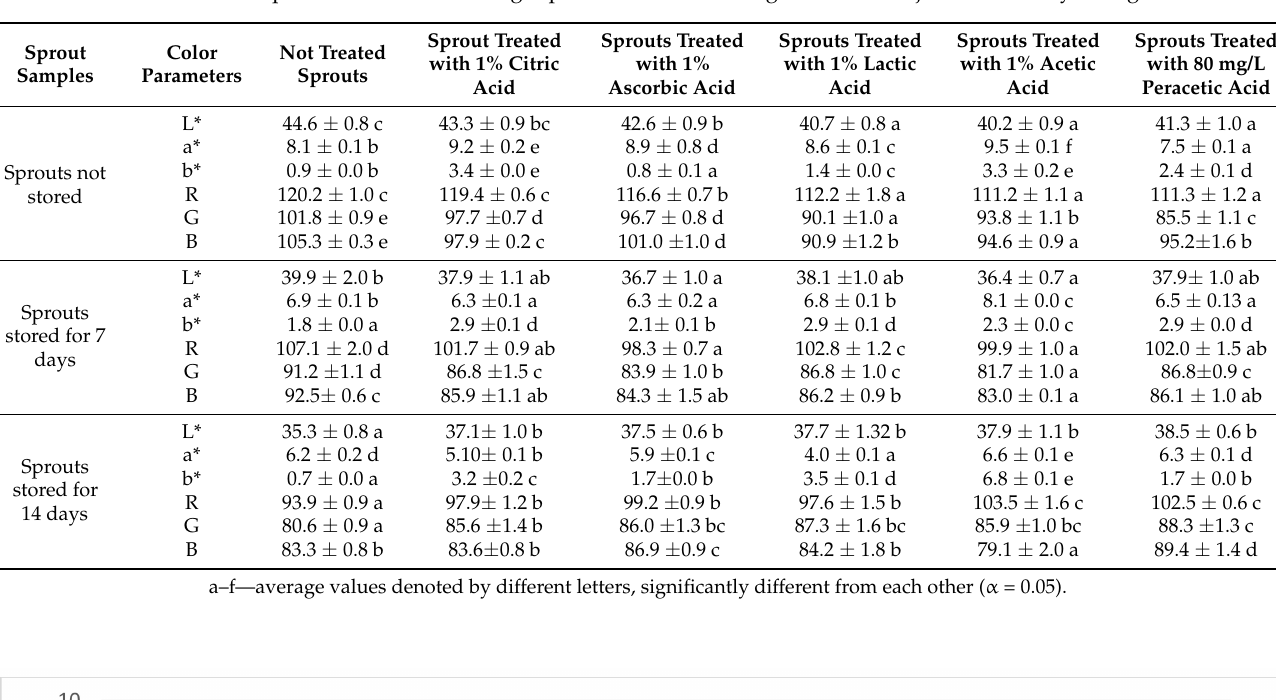
Table 7. Color parameters of red cabbage sprouts treated with organic acids subjected to 14-day storage.